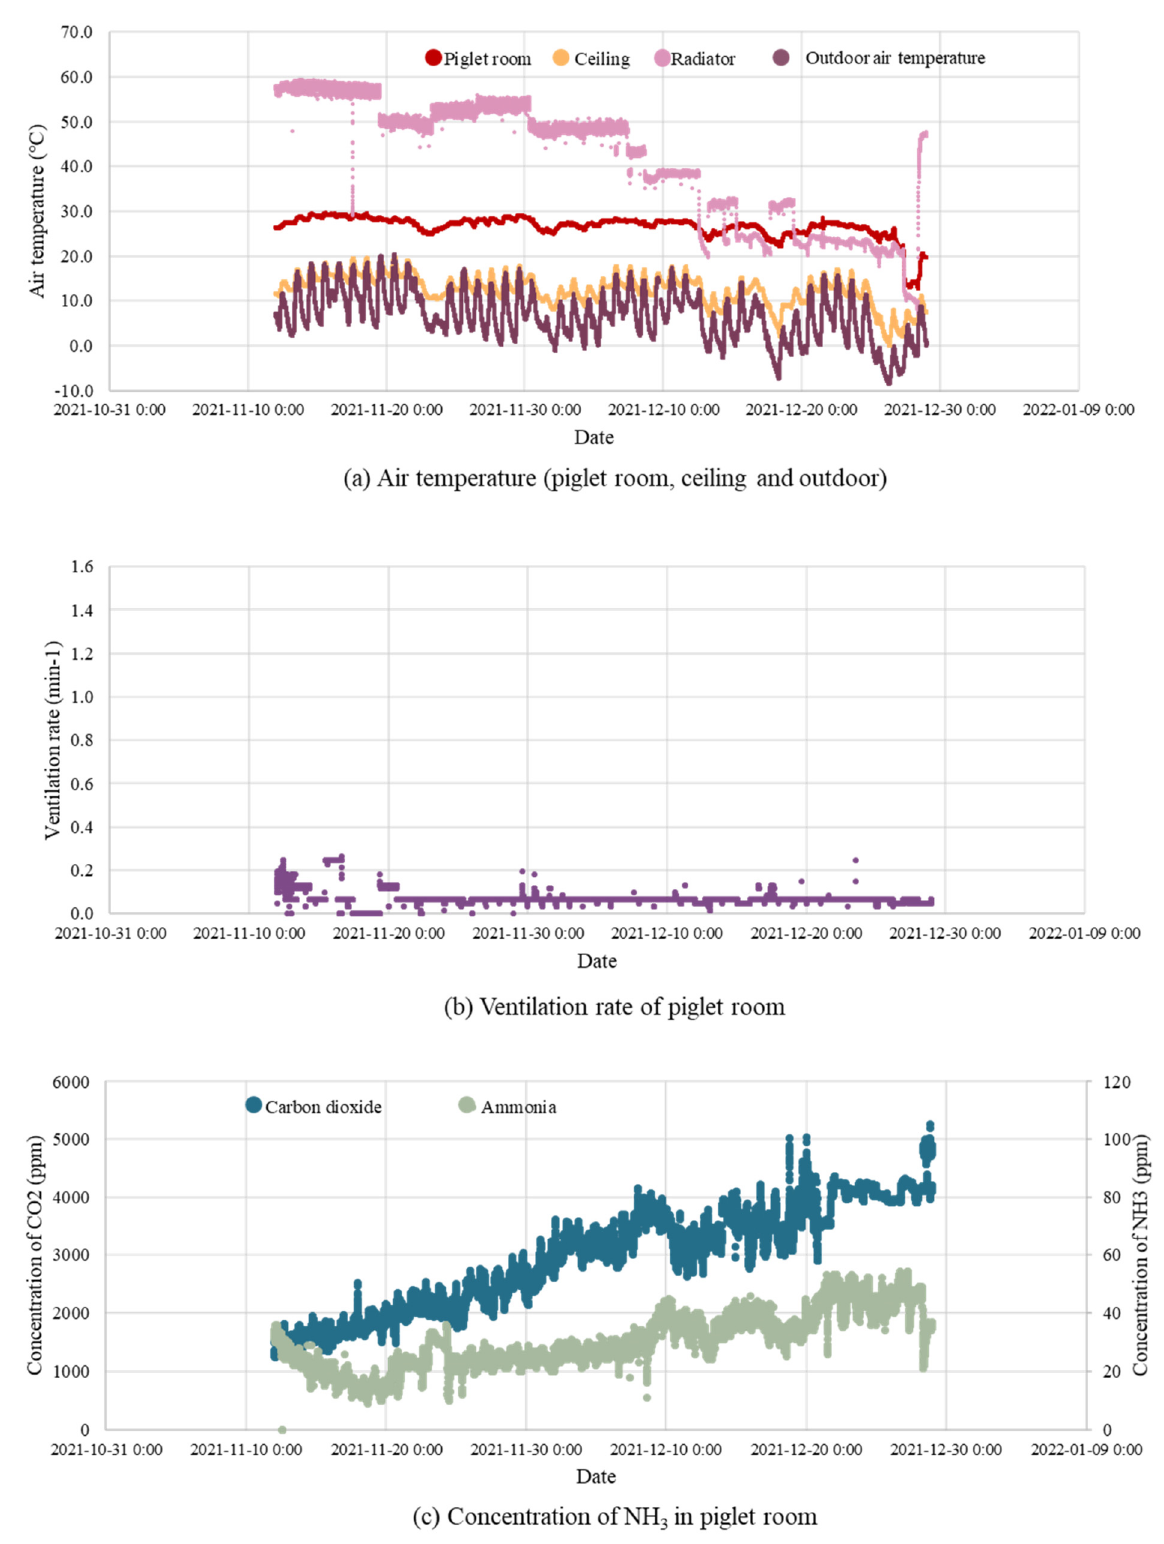
Figure 9. The air temperature, ventilation rate, and ammonia gas results measured in experimental piglet house in winter season .